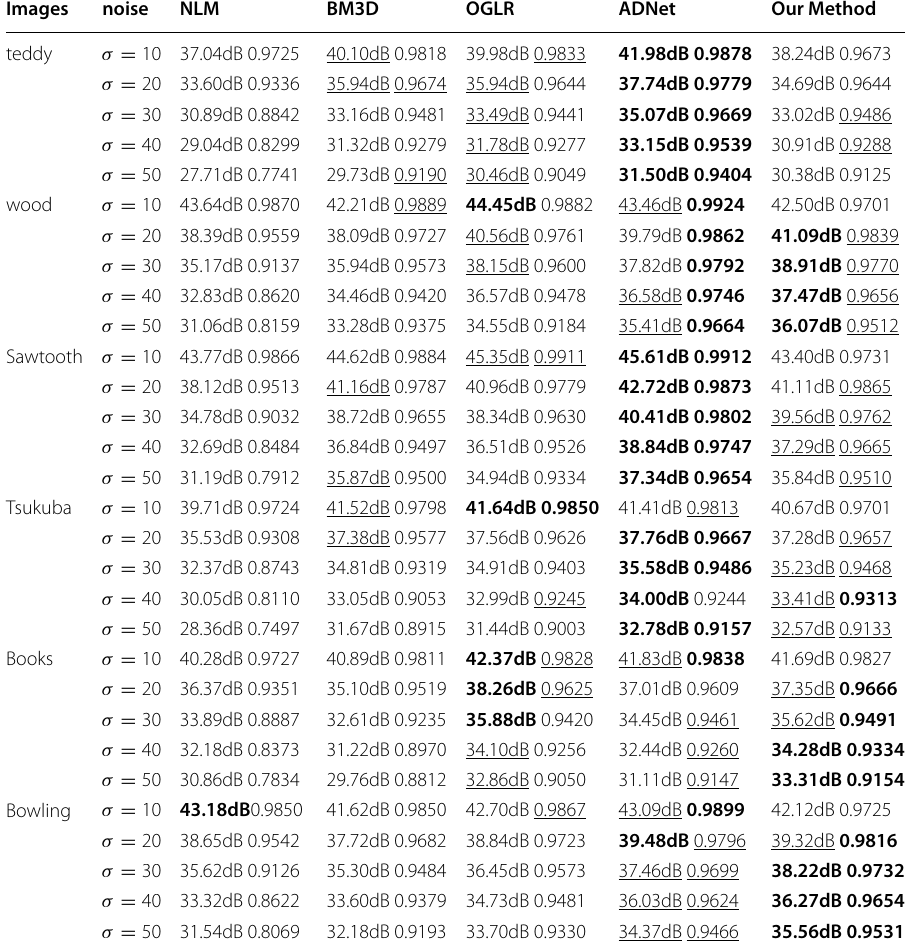
Bold and underline to mark the best and the second best results for each quality index, respectively